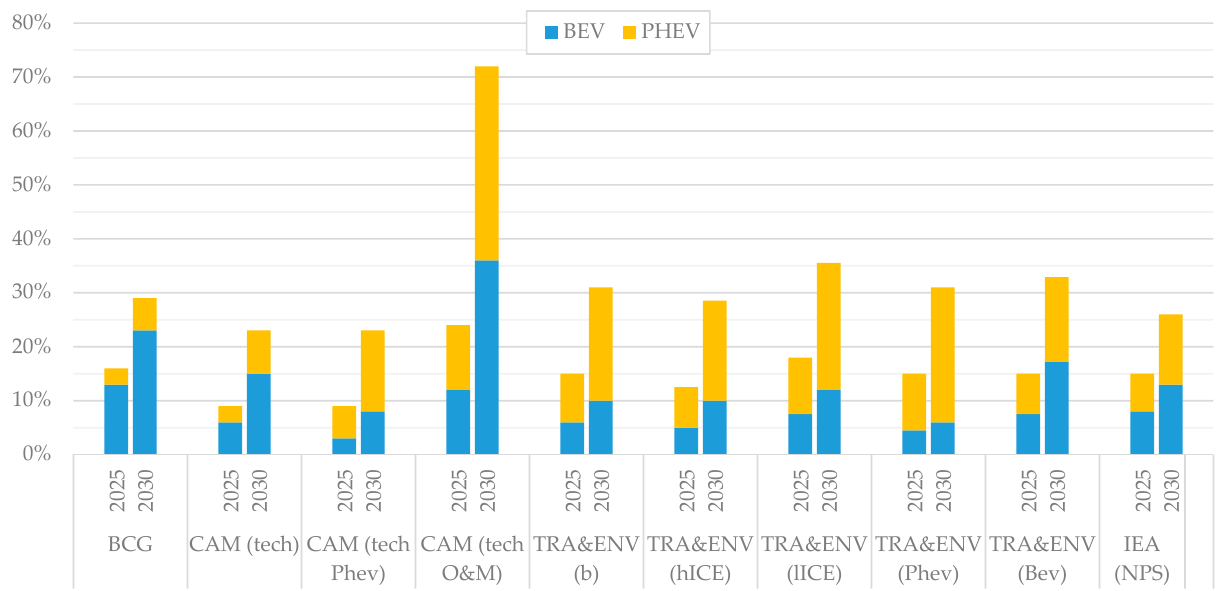
Figure 3. Estimated average BEV and PHEV penetration index on car sales, for 2025 and 2030, at European level, based on different forecasting scenarios.